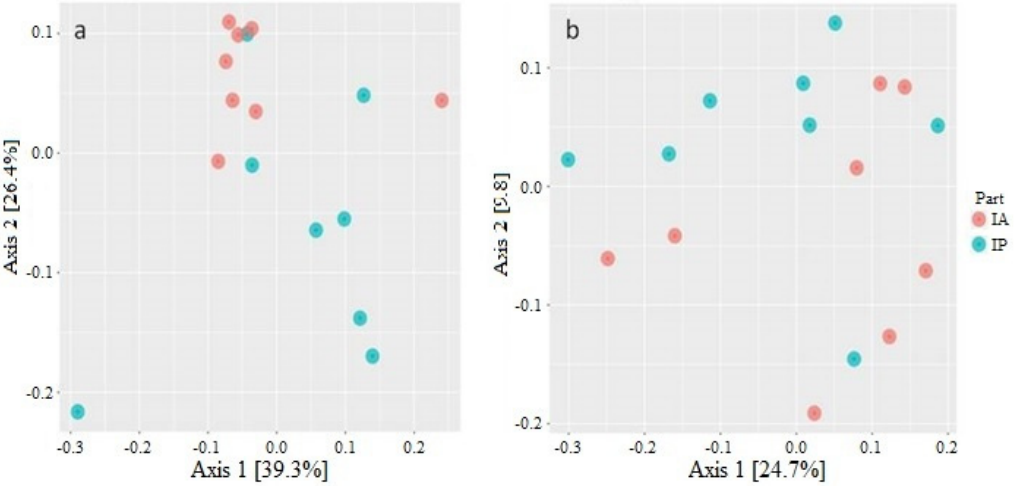
Figure 1. Principal coordinate analysis (PCoA) of the bacterial communities. ( a ) Calculated from the weighted UniFrac distance matrix and ( b ) calculated from the unweighted UniFrac distance matrix. Red circles represent samples from the intestinal anterior section and blue circles represent the intestinal posterior section of each individual of wild C. labrosus .